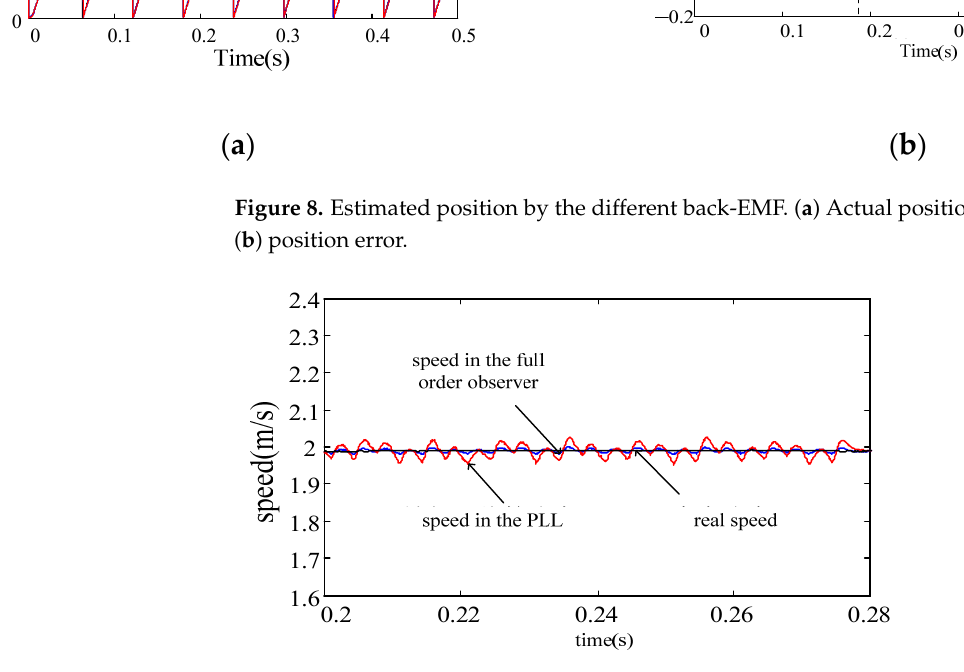
Figure 9. Comparison of speed estimation between FSO and PLL.